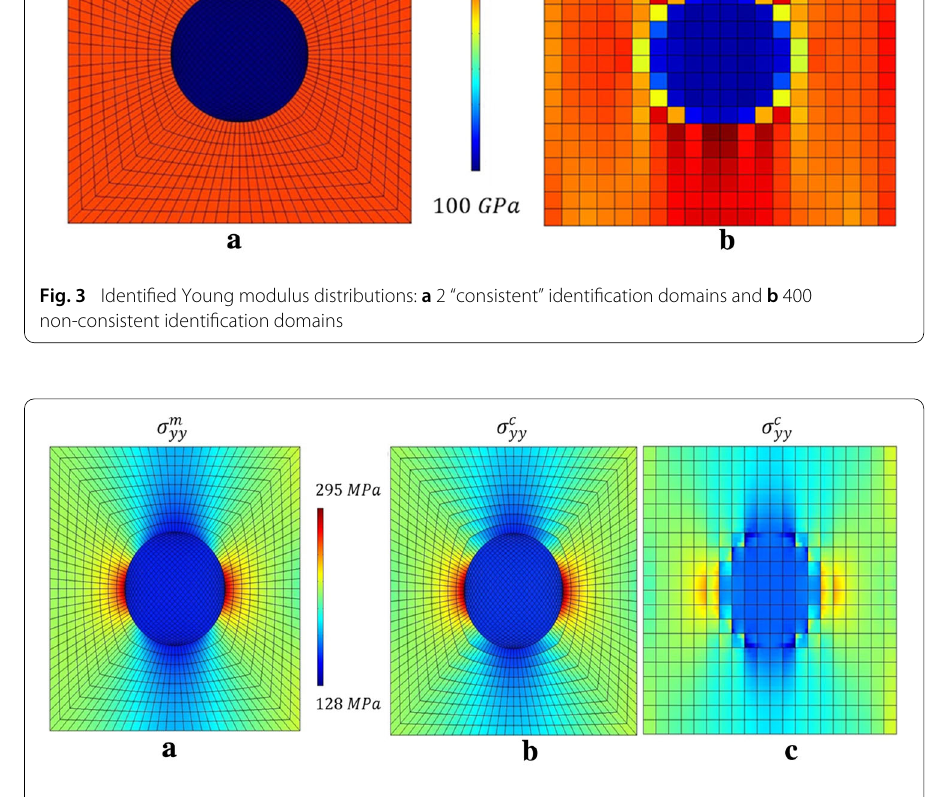
Fig. 4 Distribution of transversal stress fields: a “measured” stress field σ m yy (from FE simulation), b identified stress field σ c yy using 2 “consistent” identification domains and c identified stress field σ c yy using